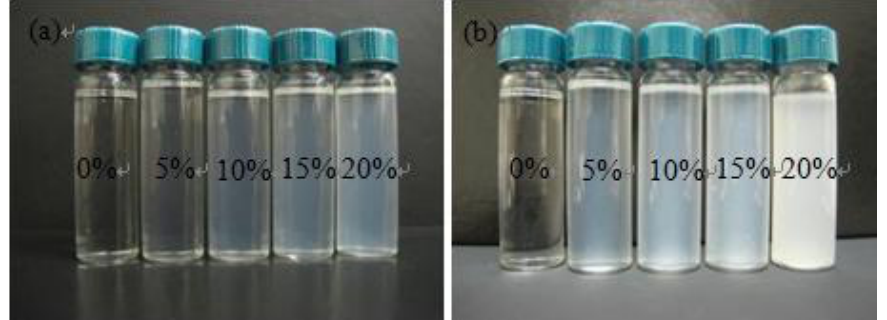
Figure 2. Polymethylmethacrylate (PMMA) and CNP/PMMA suspensions